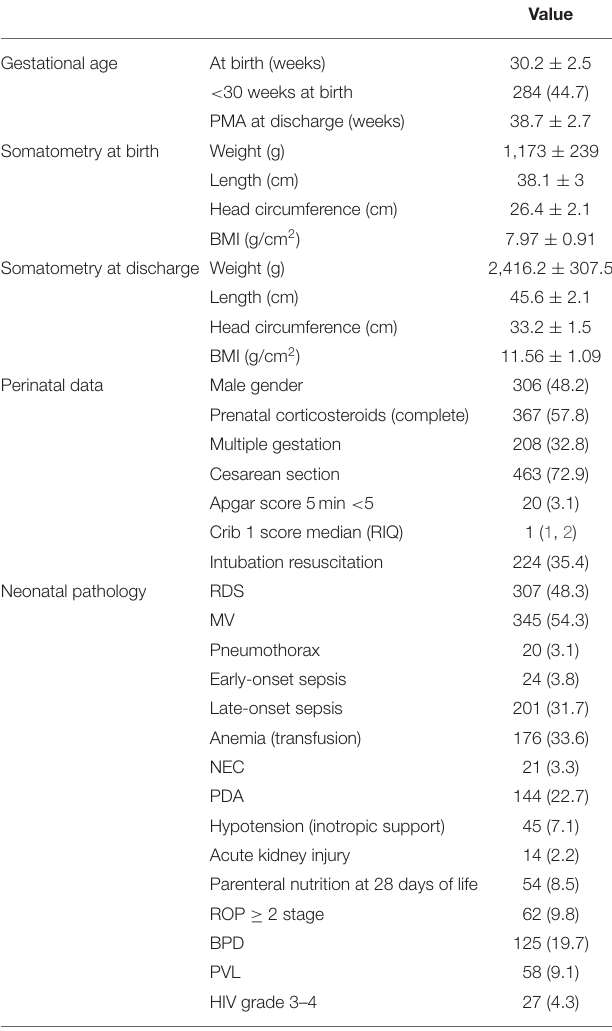
TABLE 1 | Characteristics of the study